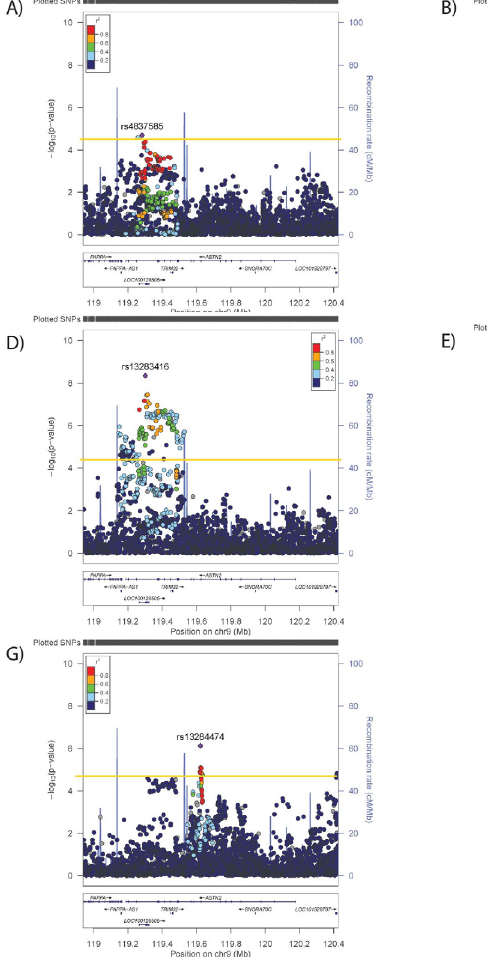
Figure 1. Regional plots for associations between ASTN2 and ( A ) SBP, ( B ) DBP, ( C ) BMI and ( D ) WHRadjBMI, ( E ) neuroticism, ( F ) anhedonia and ( G ) mood instability. Significance was set at p -value < 5.45 × 10 − 5 or − log10 > 4.26 (Horizontal yellow line). LD (r2) with the lead SNP are indicated by colour. Grey indicates that there is no LD information available.